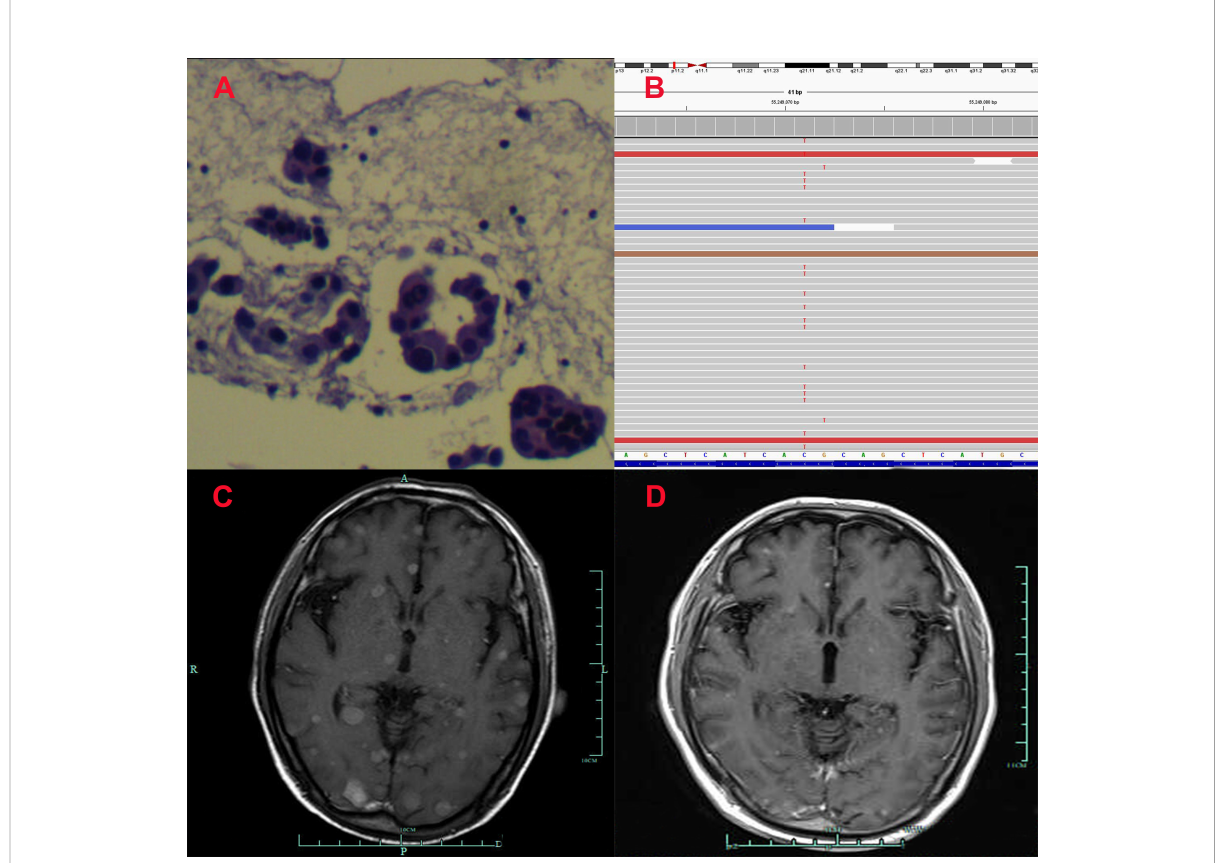
FIGURE 1 Pathological and clinical fi ndings of Patient 1. (A) Pathological fi ndings with HE staining. (B) NGS screenshots suggested emerging EGFR exon 20 T790M mutations. (C) Brain MRI image before salvage almonertinib treatment (after the emerging T790M mutation). (D) Brain MRI image after salvage almonertinib